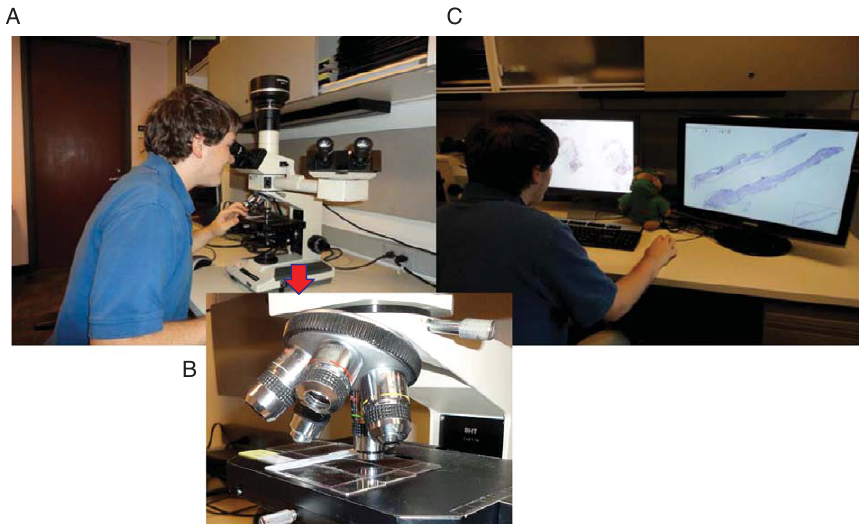
Fig. 4. Microscope usage and Multiple Display. A) A pathologist uses a microscope for diagnosis and uses his/her hand to move the slide for an efficient evaluation. B) Often, multiple slides are placed on the microscope stage to move between slides quickly. C) A WSI viewing station with multiple displays is preferred to view the WSI and make diagnosis with greater